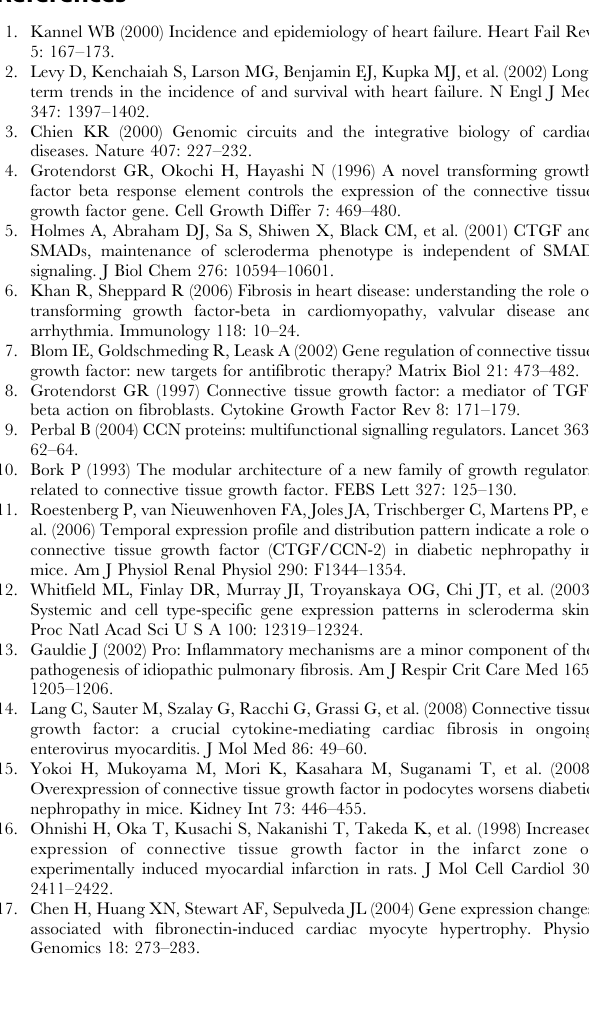
Figure S3 Characterization of cardiac function at 3 months of age in ischemia/reperfusion model. The left ventricular pressures were assessed during 5 minutes of each phase (baseline, ischemia and reperfusion). We monitored (A) intracardiac pressure in systole (ICPsys), (B) intracardiac pressure in diastole (ICPdia), (C) contraction rate (ICPsys/sec), and (D) relaxation rate (ICPdia/ sec), n= 7 mice per